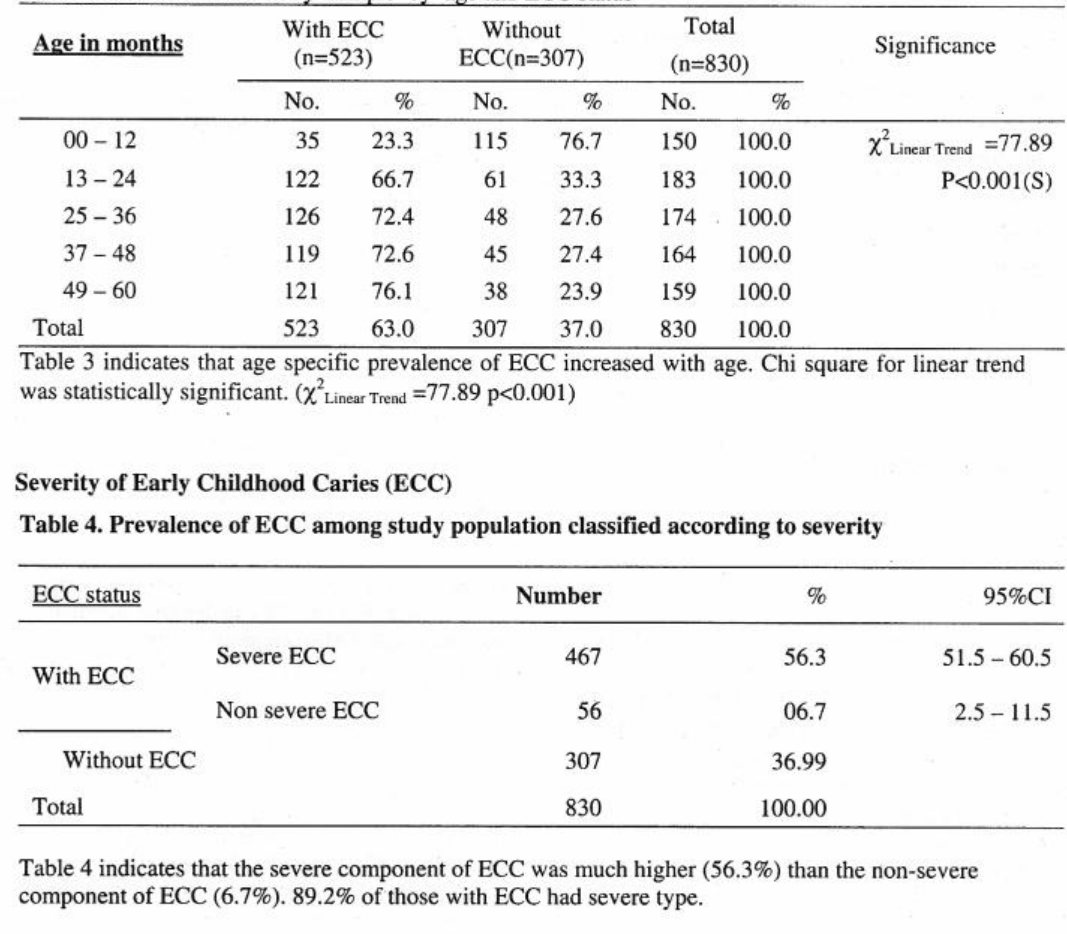
Table indicates that the overall prevalence of ECCin children below Syears was 63% (95% CI = 59.72 — 66.28). Table 3. Distribution of study sample by